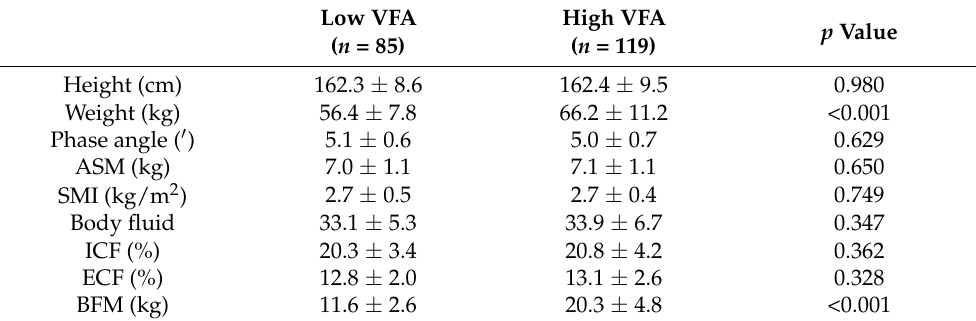
Table 4. Inbody 770 Body Composition Analysis of